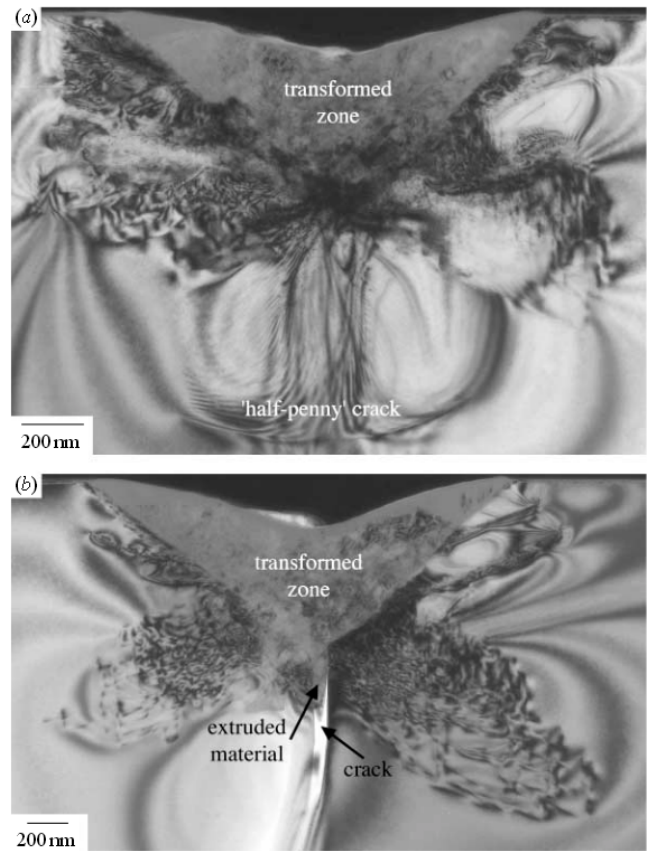
Figure 13. Bright field images of indents in silicon formed with loads of ( a ) 30 mN and ( b ) 60 mN. The structure is observed here after the load has been removed, allowing the high-pressure phase to transform back to a mixture of other structures [43]. Reproduced with permission from S.J. Lloyd et al., Philosophical Magazine A; published by Taylor & Francis,